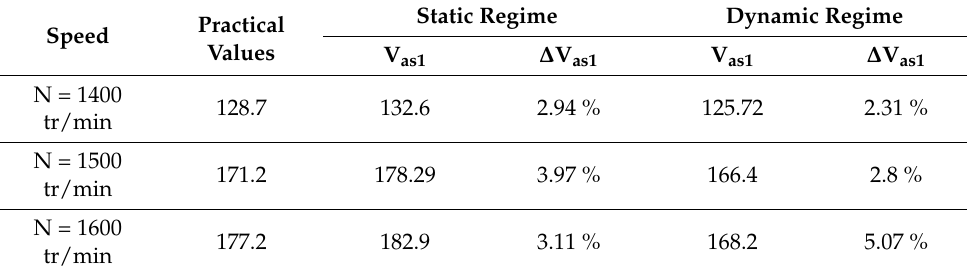
Table 4. Static and dynamic results under load with C = 9 µ F and variable speed.